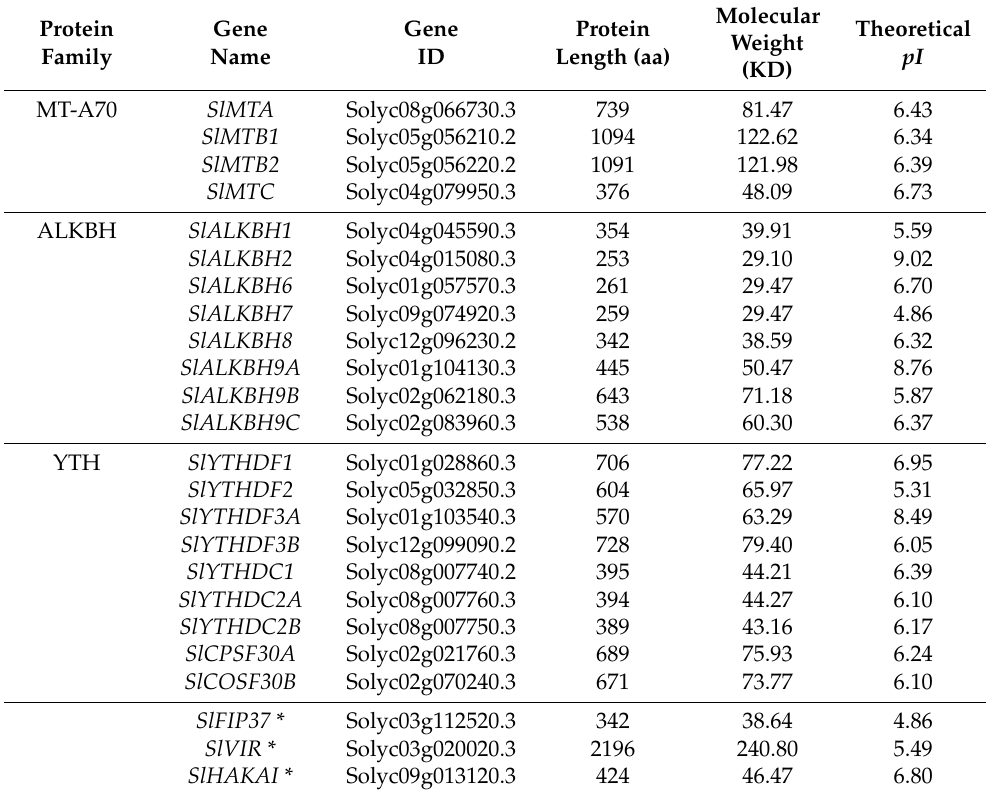
Table 1. Characteristics of the m 6 A genes identified in